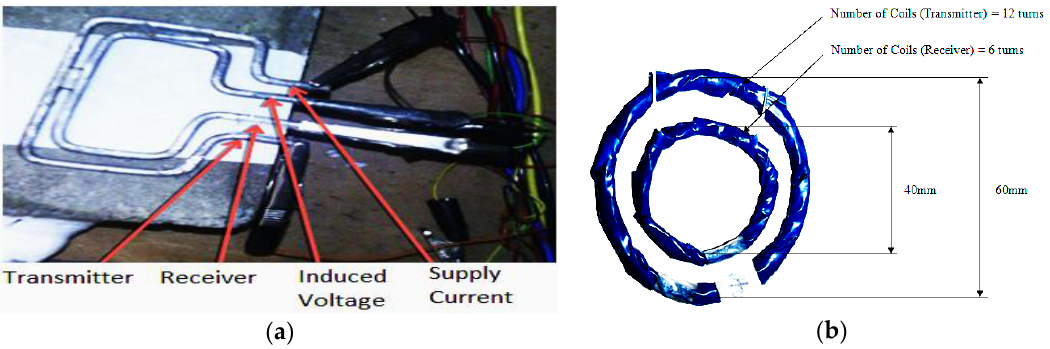
Figure 4. ( a ) Mild steel SLC setup and ( b ) multiple-loop coil (MLC) configuration made from Category 5 (CAT 5) cable.